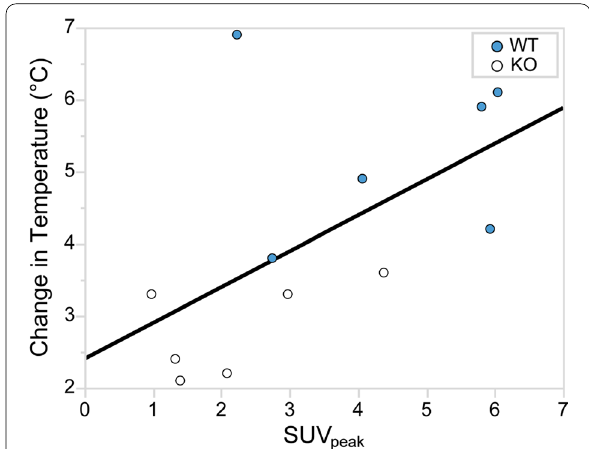
Fig. 7 Correlation between rectal temperature and SUV peak . The change in rectal temperature during [ 18 F]FDG PET/CT image acquisition is plotted against SUV peak for Set 2. Although the data show a significant correlation ( p 0.046) between the change = in rectal temperature and SUV peak during NE stimulation of BAT thermogenesis, the increase in rectal temperature, in general, cannot be taken as a surrogate measure of BAT thermogenesis